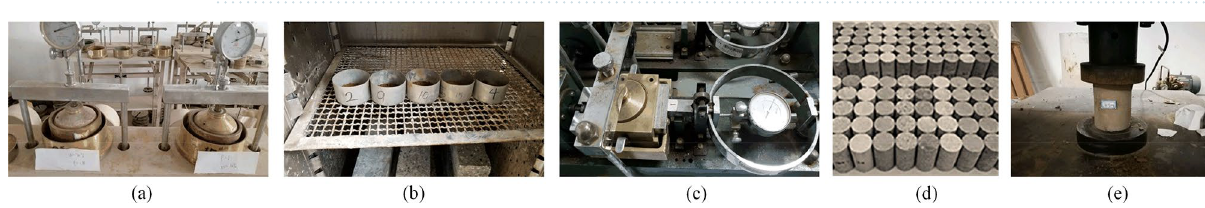
Figure. 13. Model piles and model karst caves.